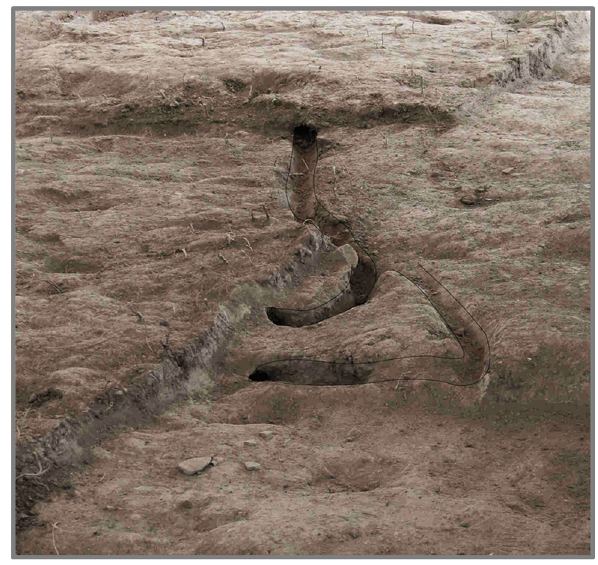
Figure 14: Çatalhöyük East. Example of actions of burrowing animals. ( Photo by K. Paw ł owska )